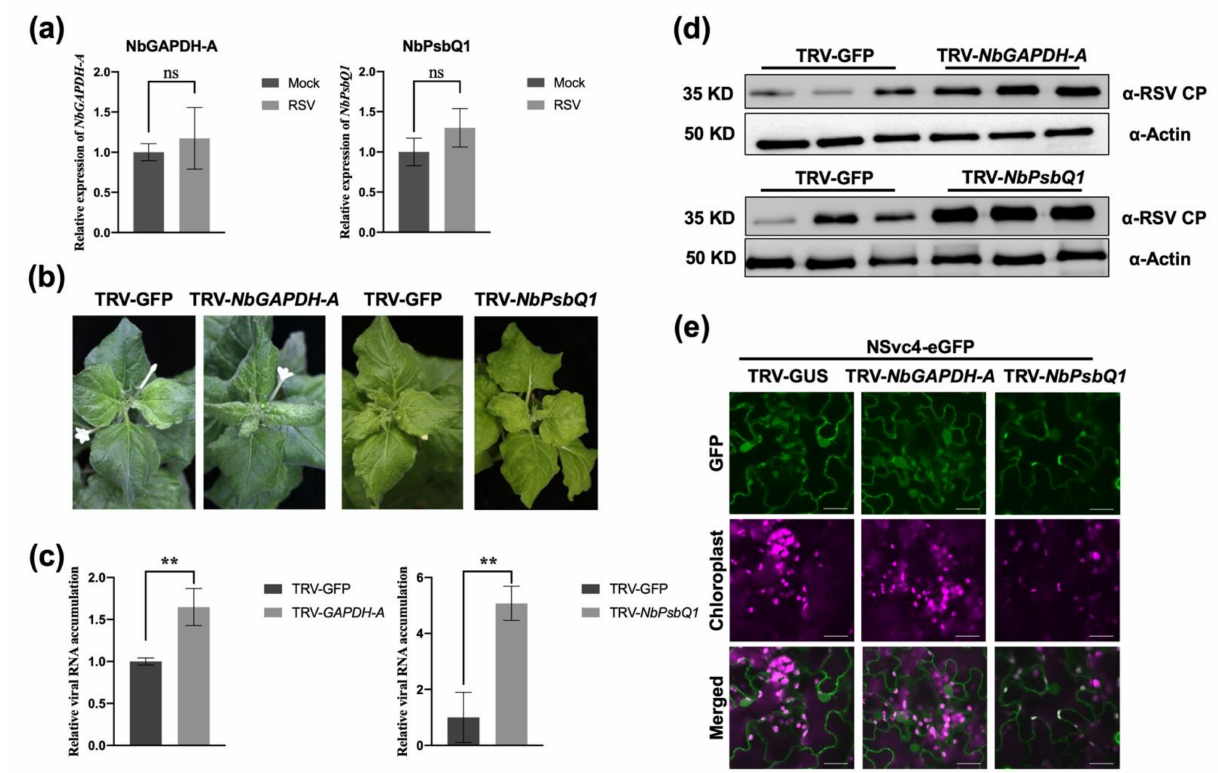
Figure 5. Chloroplast-related factors are involved in the regulation of RSV infection. ( a ) The relative expression levels of NbGAPDH-A and NbPsbQ1 in RSV-infected or wild-type N. benthamiana leaves at 12 dpi were assayed by qRT-PCR, with NbActin as a reference gene for normalization. Data were analyzed by Student’s t -test, and asterisks denote significant differences between RSV-infected and mock plants (two-sided, n = 3; ns, not significant). ( b ) The symptoms of TRV-GFP, TRV- NbGAPDH-A , and TRV- NbPsbQ1 RSV-inoculated plants at 11 dpi of RSV. ( c ) Detection of viral RNA accumulation in TRV-GFP, TRV- NbGAPDH-A , and TRV- NbPsbQ1 RSV-inoculated plants. The leaves from RSV-infected plants in ( b ) were harvested. Total RNA was extracted for RT-qPCR to detect the transcription level of RSV CP. NbActin was used as a reference gene for normalization. Data were analyzed by Student’s t -test, and asterisks denote significant differences between TRV-GFP plants and TRV- NbGAPDH-A or TRV- NbPsbQ1 plants (two-sided, n = 3, ** p < 0.01). ( d ) Detection of RSV CP accumulation in TRV-GFP, TRV- NbGAPDH-A , and TRV- NbPsbQ1 RSV-inoculated plants. The leaves from RSV-infected plants in ( b ) were harvested. Total protein was extracted for Western blotting. The protein level of RSV CP represented the virus accumulation level. Actin was used as a loading control. ( e ) Subcellular localization of NSvc4-eGFP in NbGAPDH-A -silenced, NbPsbQ1 -silenced, and TRV-GUS control